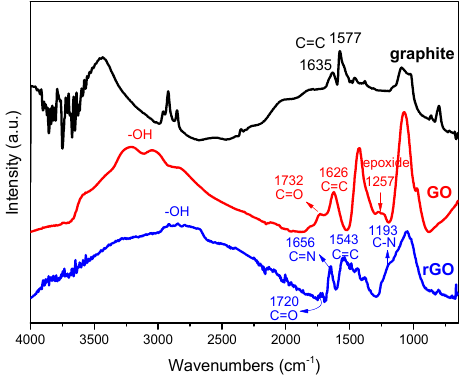
Figure 3. Attenuated total reflectance Fourier transform infrared (ATR-FTIR) spectra of graphite, GO, and rGO. Table 3. Intensity ratios of polar groups to C=C band for GO and rGO.